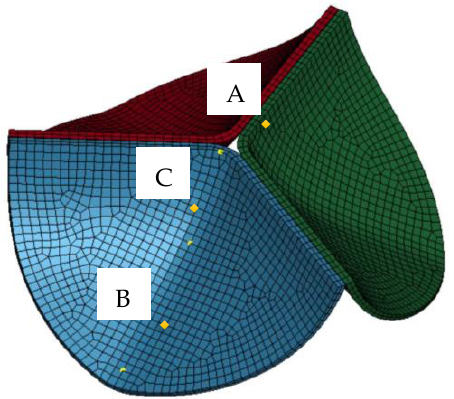
Figure 15. The location of node A, B, and C of the 3D model of asymmetry tri-leaflet.